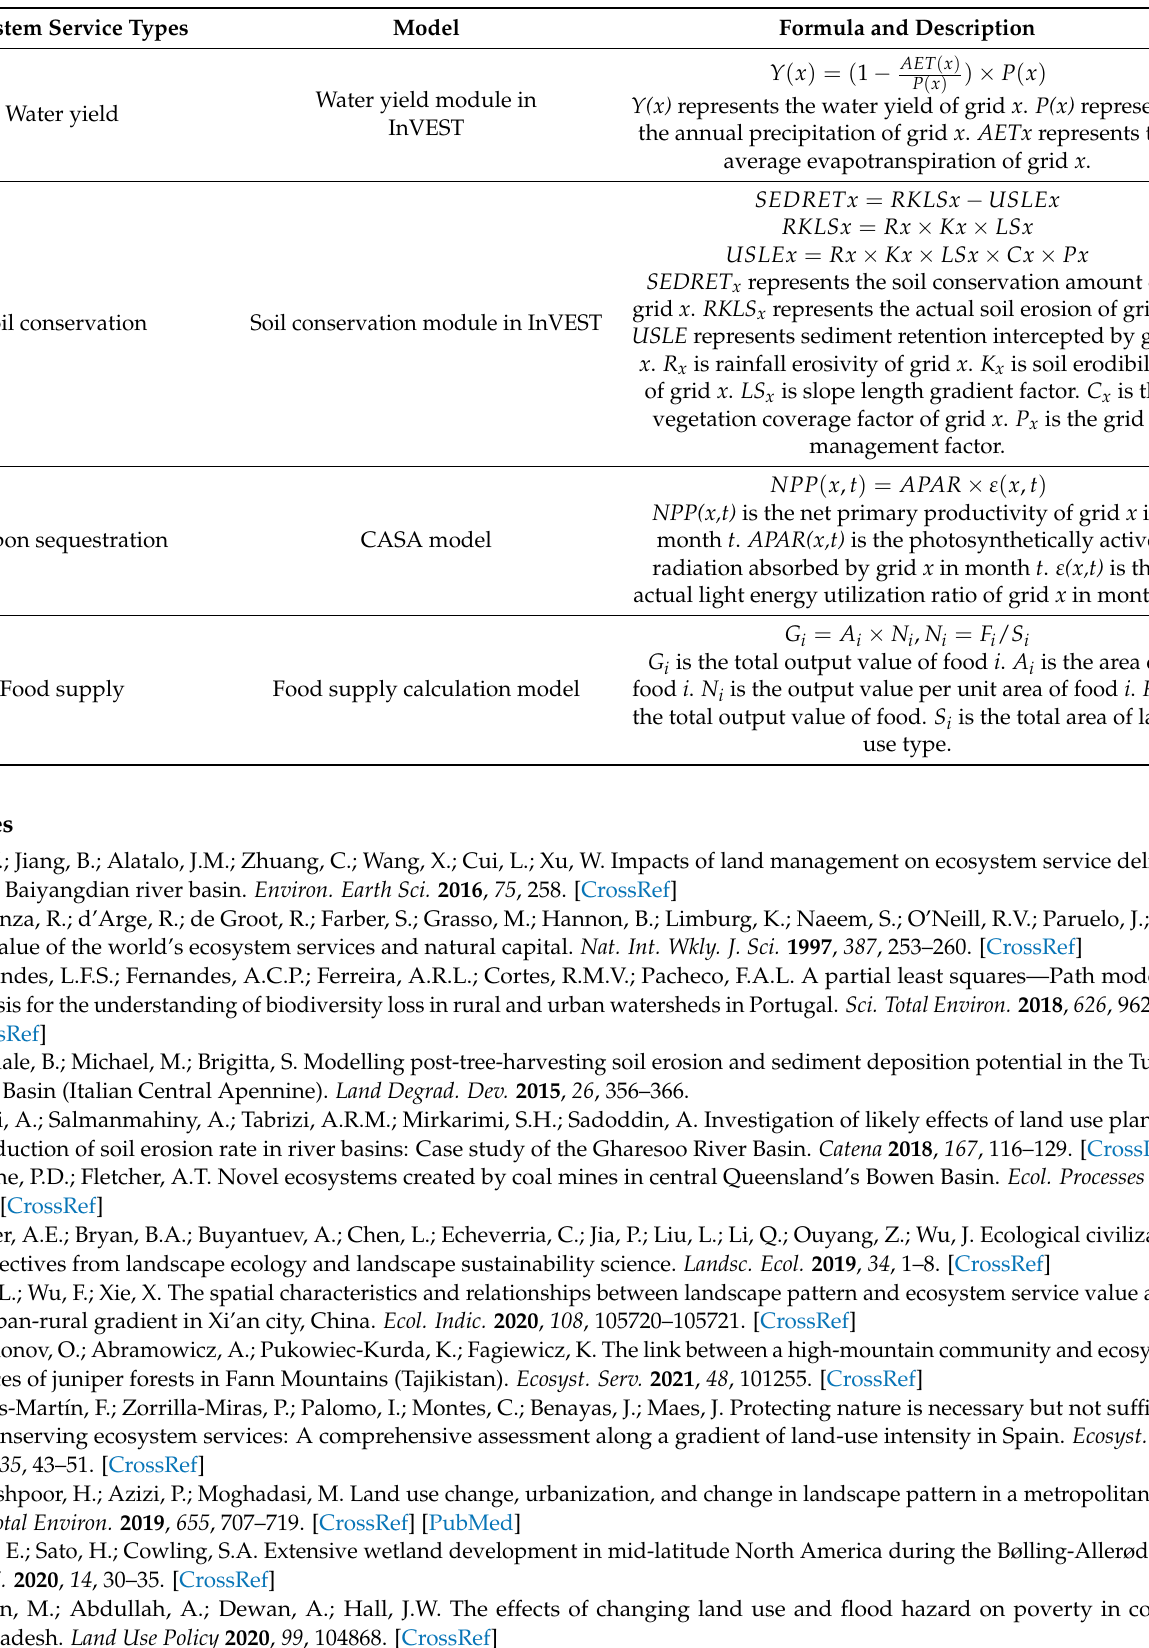
Table A5. Ecosystem services